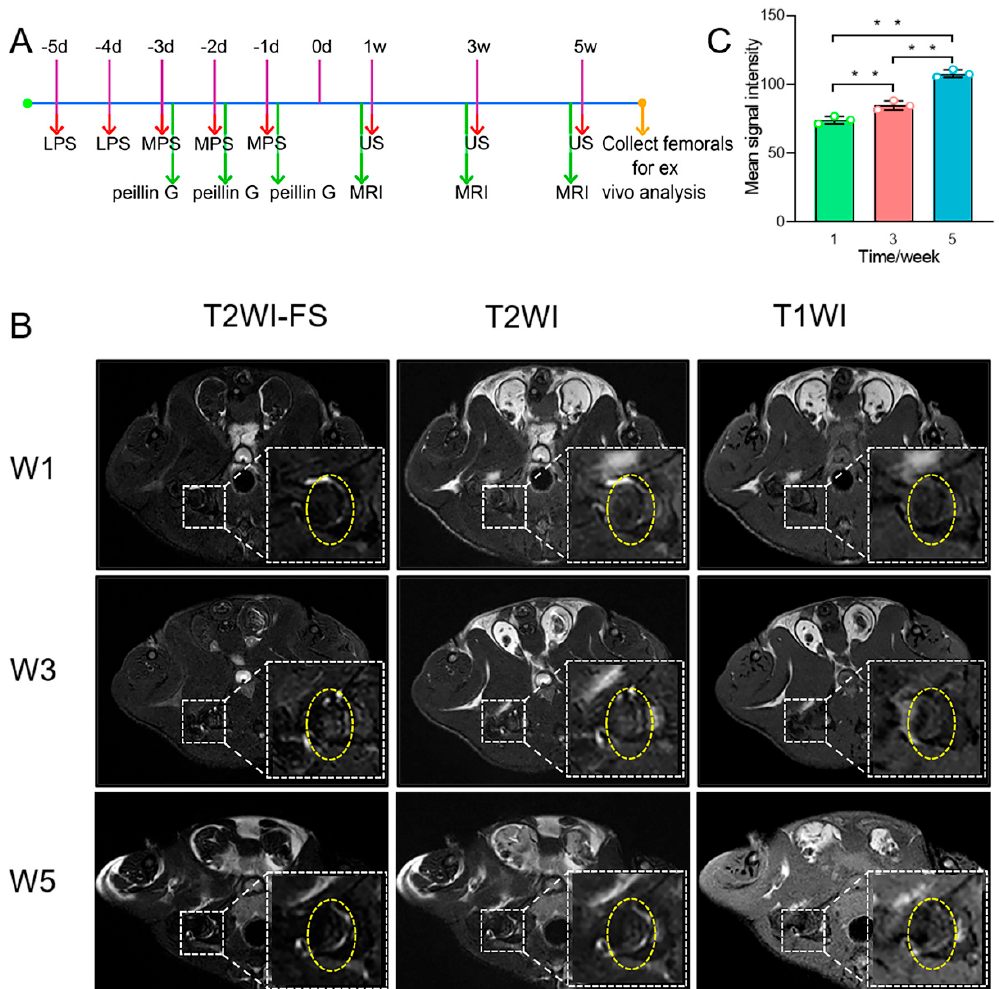
Figure 4. The establishment of ONFH model and MRI evaluation. ( A ) Flow diagram summarizes experimental design of the establishment of ONFH model. ( B ) The model of ONFH was monitored by MRI with three sequences (T2WI-FS, T2WI and T1WI) at 1 week, 3 weeks and 5 weeks. ( C ) Quan- titative analysis of signal intensities for the T2WI. Data were analyzed by one-way ANOVA, and multiple comparisons of LSD were chosen as post hoc tests (** p < 0.05).